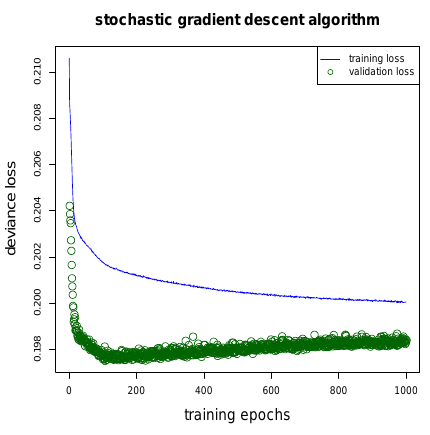
Figure 1. Gradient descent network fitting: training losses on D ( − ) in blue color and validation losses on V in green color; note that the keras library drops all constants in deviance losses during gradient descent calibration, for this reason is the y -scale different compared to Table 2.